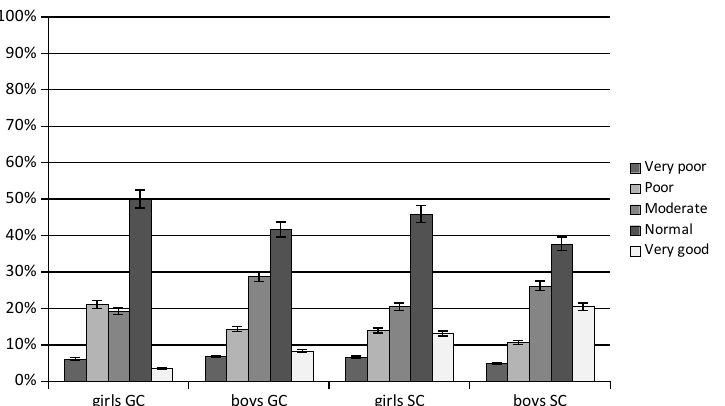
Figure 2. Results of the long jump test from a standing position, an average over the study period. GC—general education classes; SC—sport classes.